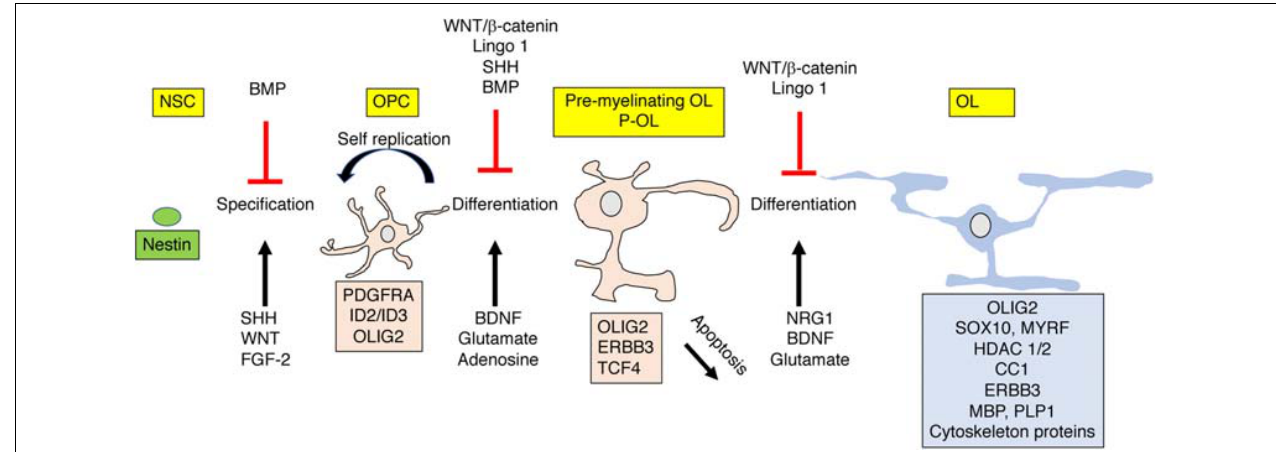
FIGURE 4 | OPC differentiation and apoptosis are highly regulated by external signals. Nestin positive polypotent NSC differentiate into lineage specific OPC that give rise to pre-myelinating (P-OL) or undergo apoptosis. P-OL then differentiate into mature OL. These processes are tightly controlled by diffusible and non-diffusible molecules expressed by active or non-active axons. These instructive molecules can promote (black ↑ ) or inhibit (red ⊥ ) these processes by altering gene expression in these cells (shown as a box with matching color). Genes and proteins shown represent only a partial list of key molecules discussed in the text. For more comprehensive reviews see Mitew et al. (2014), Foster et al. (2019). NSC, polypotent neural stem cell; OPC, oligodendrocyte progenitor cells; P-OL, pre-myelinating oligodendrocytes; OL, mature oligodendrocytes.